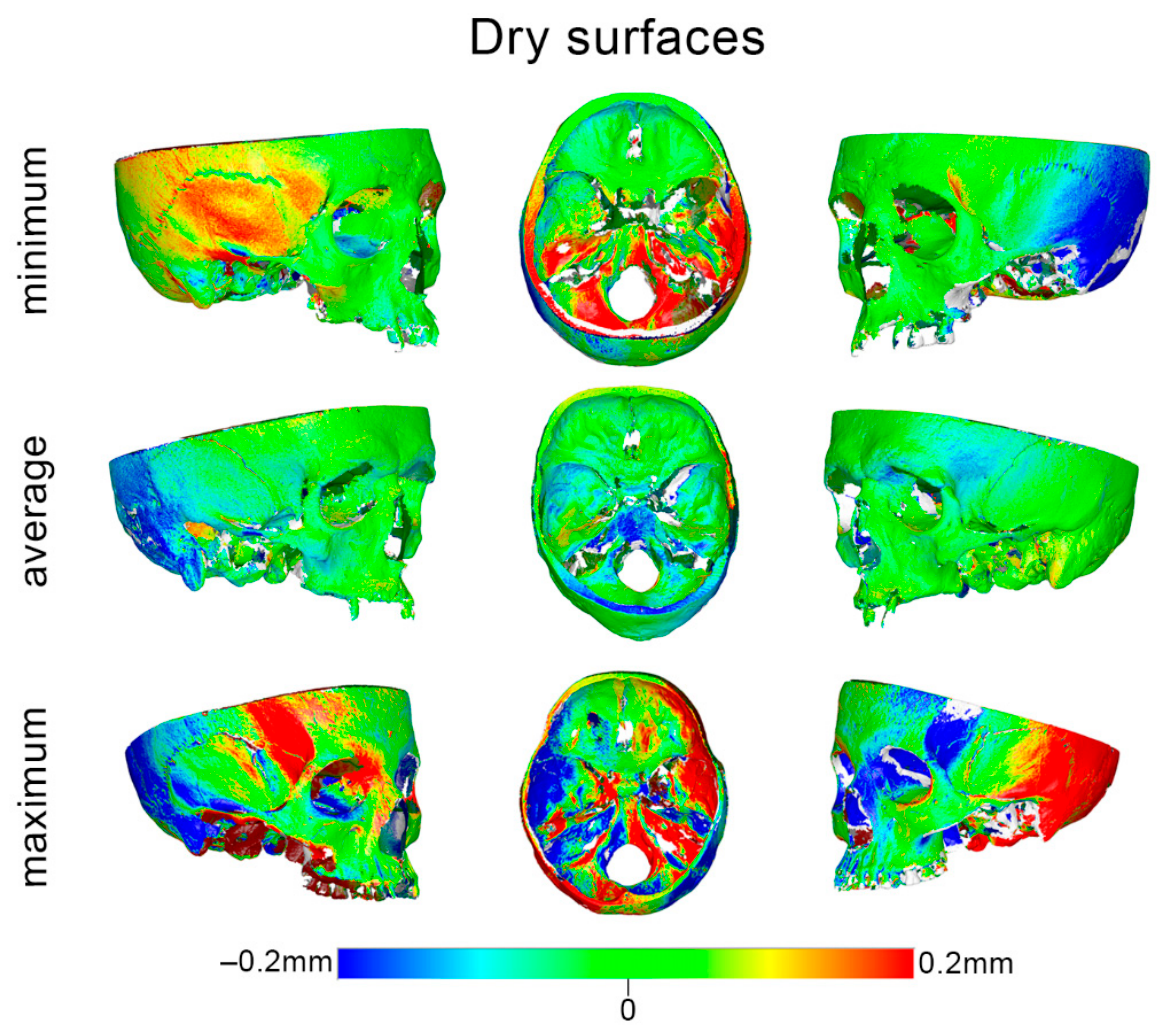
Figure 5. Color-coded distance maps of skulls showing the scanner reproducibility, depicted through selected models that corresponded to the minimum, average, and maximum error detected in the pre-specified measurement areas. Zero distance between best-fit-approximated repeated scans indicates perfect reproducibility.